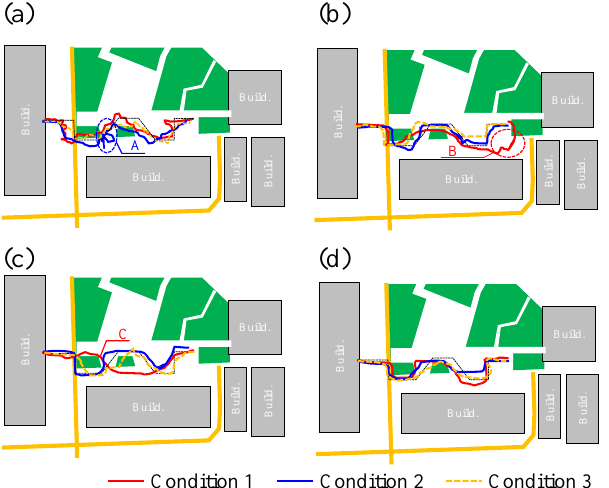
Figure 13. Walking paths of the four subjects from ( a – d ).